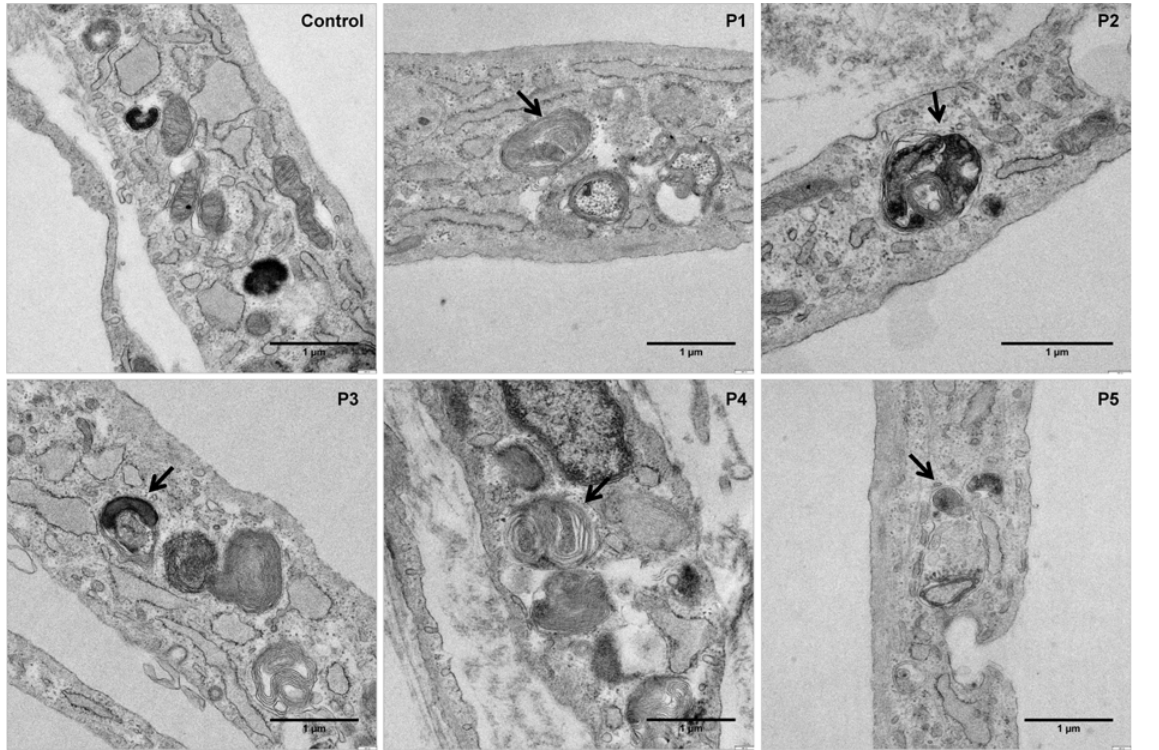
Fig 8. Mitochondrial ultrastructure analysis. Representative electron micrographs of control- and patients-derived fibroblasts. Control fibroblasts showed mitochondria with typical ultrastructure. Laminar bodies and autophagosomes with mitochondria were observed in patients´ fibroblasts. (Bar = 1 μ m).